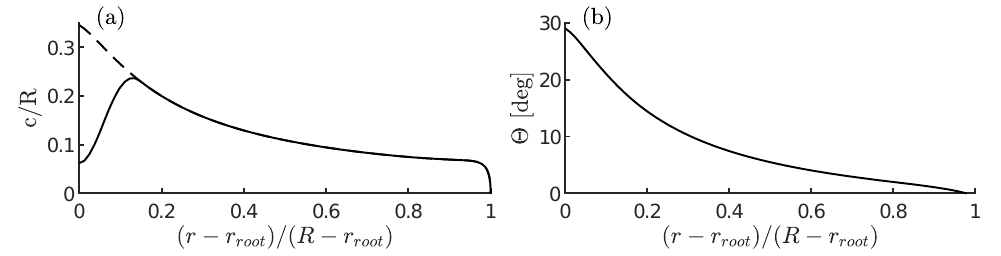
Figure 4. ( a ) Chord and ( b ) Twist distribution. Dashed line represents Burton’s optimum distribution and solid line is the modified distribution.